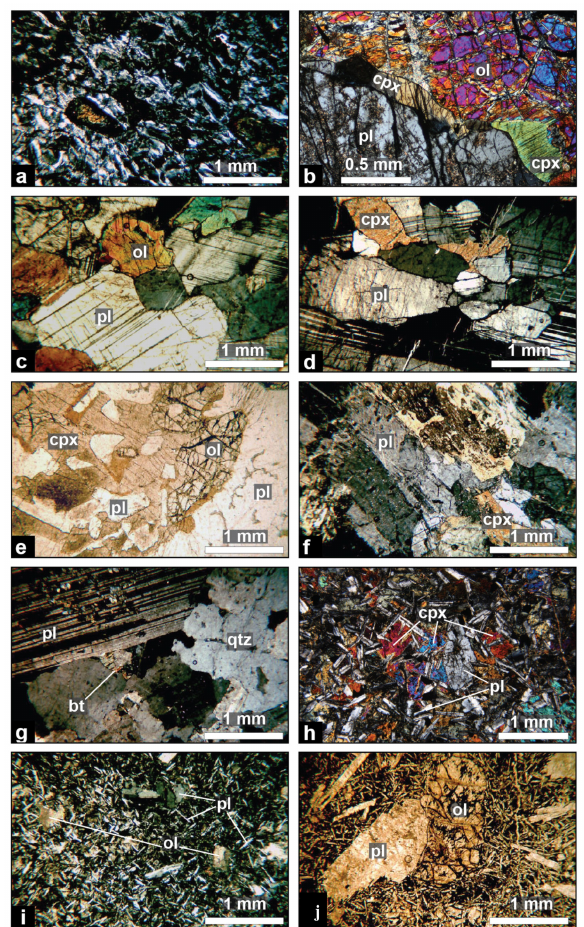
Figure 5. Photomicrograph of intrusive ( a – g ), subvolcanic ( h ), and volcanic ( i , j ) rocks from the Band-e-Zeyarat ophiolite: ( a ) serpentinized dunites showing relicts of magmatic olivine, ( b ) cumulitic texture in troctolite showing large olivine and plagioclase crystals and inter-cumulus clinopyroxene, ( c ) cumulitictextureingabbroshowingroundedolivinecrystalsandsubhedralplagioclase, ( d )cumulitic leucogabbro showing inter-cumulus clinopyroxene and magmatic foliation defined by preferential orientation of plagioclase crystals, ( e ) ipidiomorphic texture in gabbro showing crystallization order olivine + plagioclase + clinopyroxene, ( f ) autoallotriomorphic texture showing subhedral plagioclase and clinopyroxene, ( g ) euhedral plagioclase and anhedral quartz in plagiogranite, ( h ) subophitic texture in basaltic dyke from the sheeted dyke, ( i ) aphyric and weakly porphyritic ( j ) pillow lava showing intersertal texture with plagioclase microlites set in altered volcanic